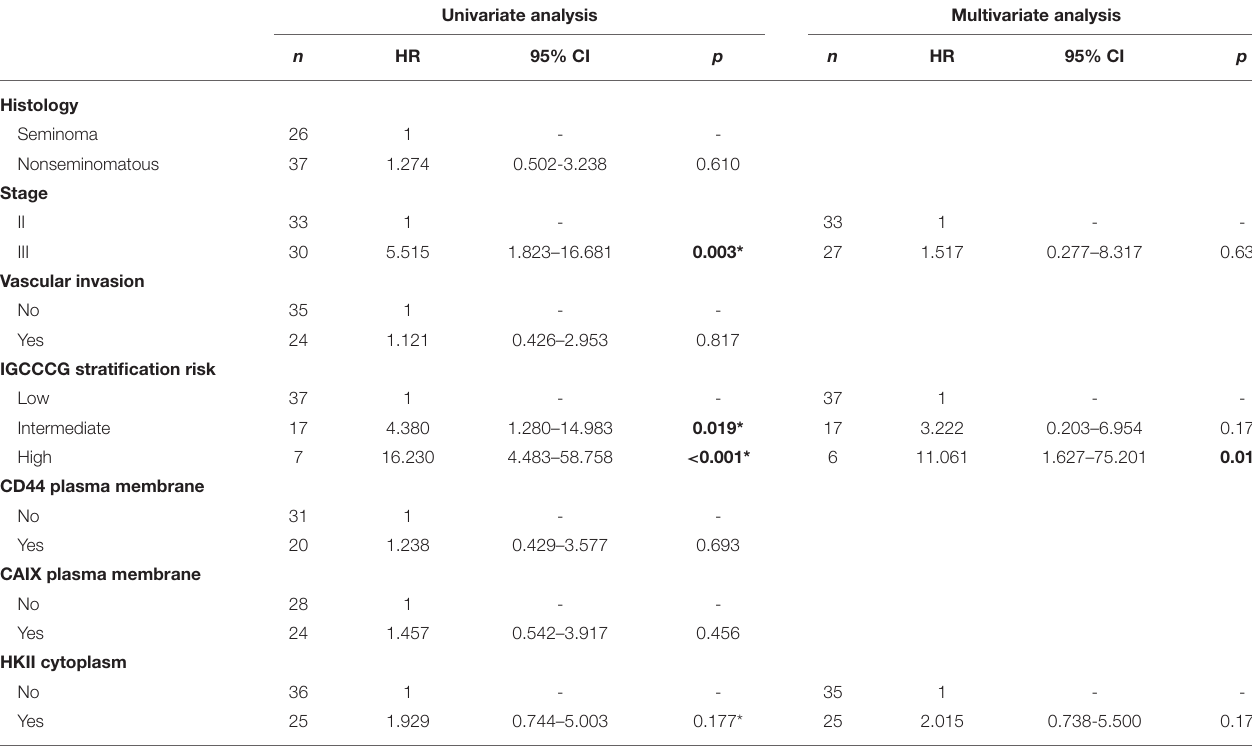
TABLE 5 | Prognostic factors for event-free survival in adult testicular germ cell tumors.